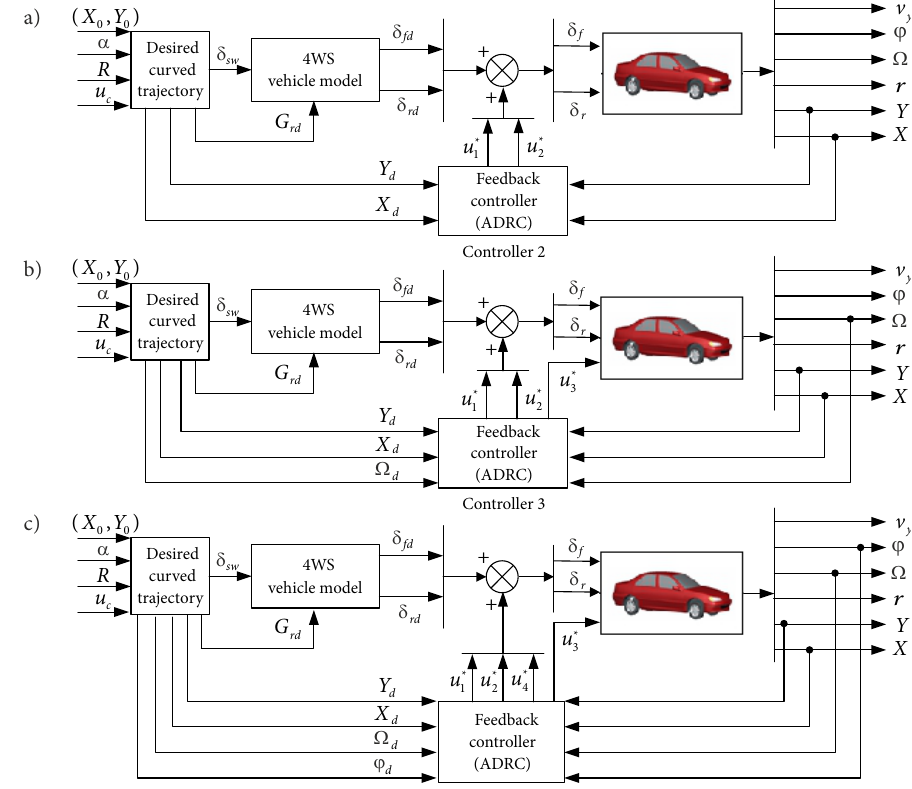
Figure 3. Overall block diagrams: a – controller 2; b – controller 3; c – controller